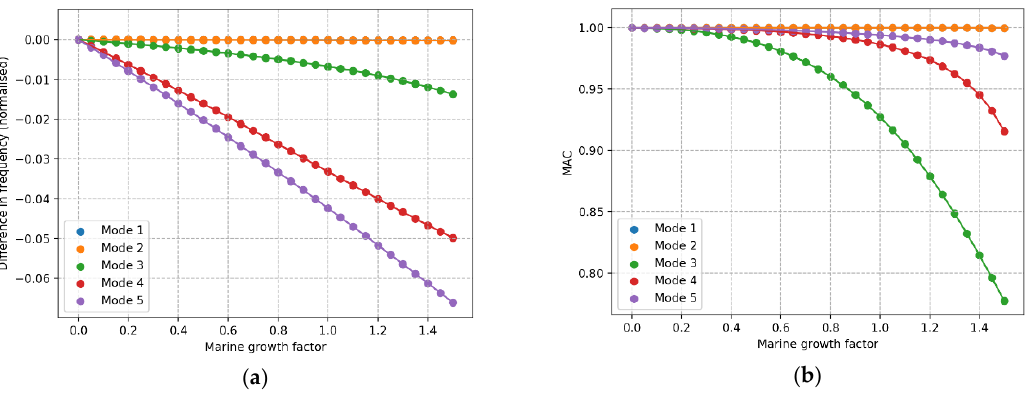
Figure 17. Effect of marine growth relative to the unfouled structure. ( a ) Change in frequency, ( b ) MAC values.